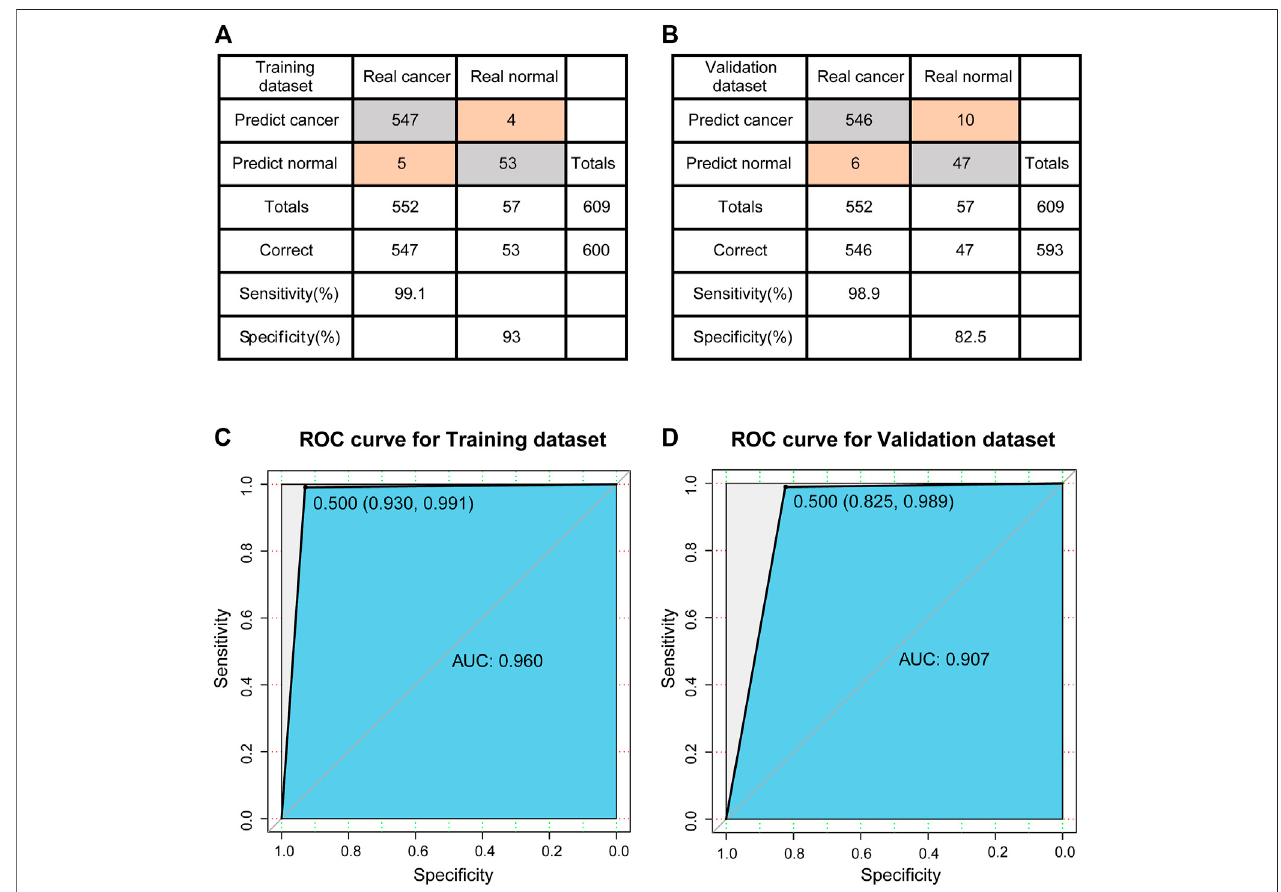
FIGURE 4 | Evaluation of classi fi cation models. (A) The confusion matrix of Training dataset. (B) The confusion matrix of Validation dataset. (C) ROC curve of Training dataset. (D) ROC curve of Validation dataset.